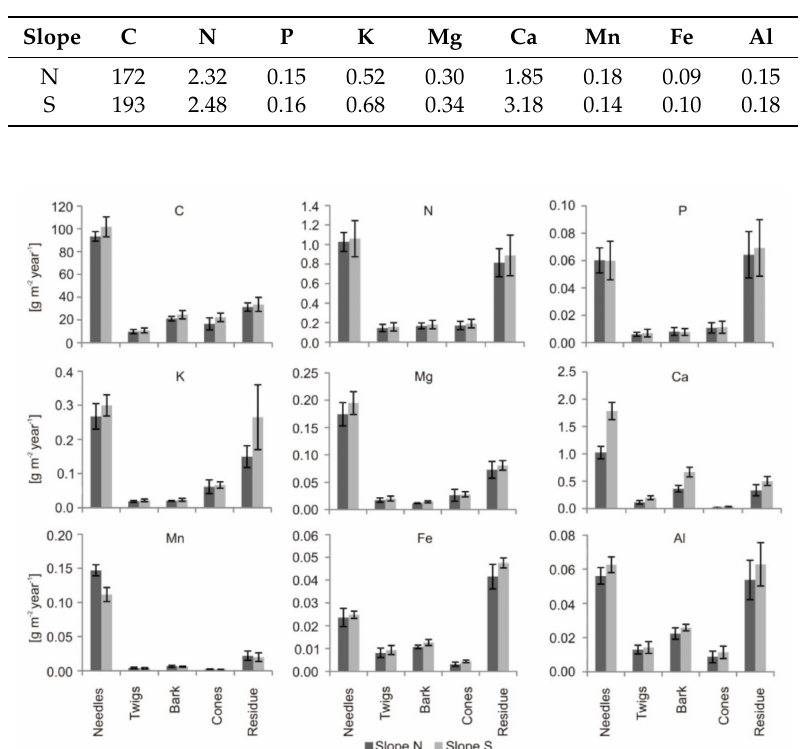
Figure 3. Return of elements to soil with particular categories of litterfall on slopes N and